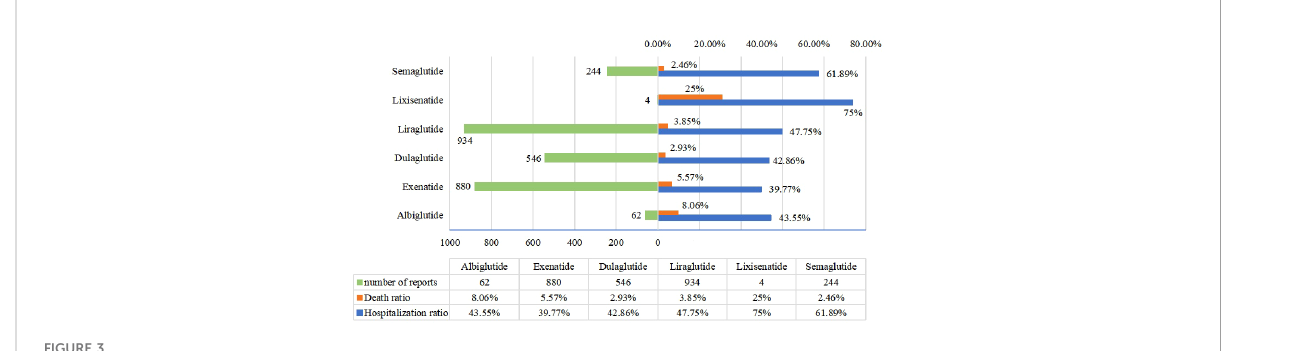
FIGURE 3 Mortality and hospitalization rate of acute kidney injury caused by